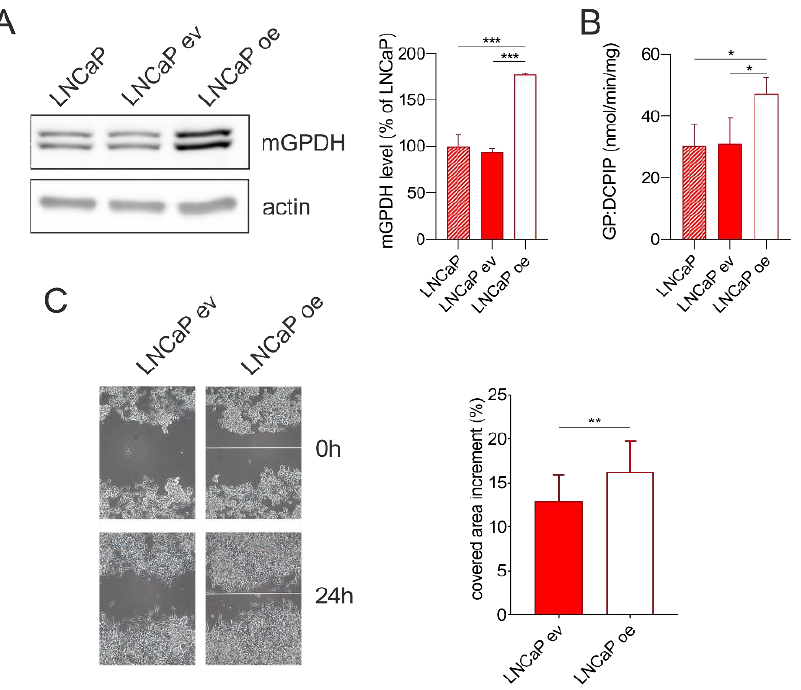
Figure 5. Wound healing assay in LNCaP cells without transfection, stably transfected with a control pcDNA3.1( + ) vector (LNCaP ev) or vector containing mGPDH (untagged form; LNCaP oe). ( A ) Cell lysates (15 µ g) were separated on SDS-PAGE and analyzed by Western blotting using antibodies against mGPDH and actin. A representative Western blot and quantification of total mGPDH amount is shown ( n = 3). ( B ) Enzyme activity of mGPDH measured spectrophotometrically in cell lysates using glycerol-3-phosphate as a substrate ( n = 3). ( C ) Analysis of cell migration by in vitro scratch assay. Images were acquired at 0 and 24 h. Representative images and quantification of covered area increment ( n = 15). Data represent the means ± S.D., * p < 0.05, ** p < 0.01, *** p < 0.001.